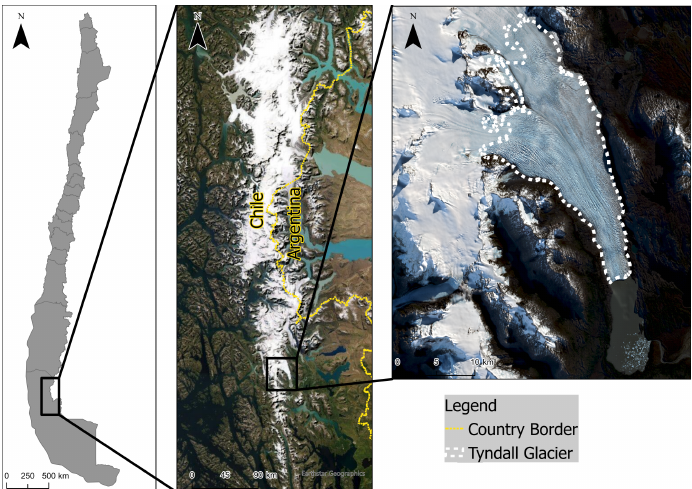
Figure 1. Overview of the processing steps applied in this study to carry out a classification of Sentinel-2 imagery and to conduct a multi-temporal analysis on that basis. For each time step, a pixel-wise classification of multi-spectral data with respect to the given different snow and ice types is performed. Subsequently, achieved classification results are merged in the scope of a multi-temporal analysis to assess changes in glacier extent and surface composition. A particular challenge is given with the fact that no reference data are available for the considered classification task, so that appropriate reference data have to be generated from theoretical knowledge about corresponding spectral signatures.